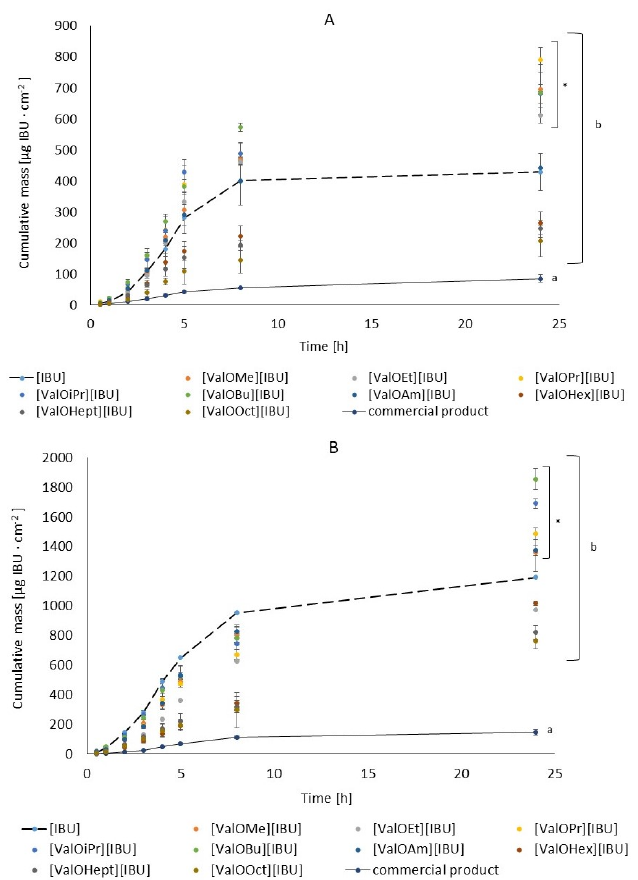
Figure 2. Time course of the cumulative amount of [IBU] and its modifications that permeated through human skin ( A ) and Strat-M™ ( B ). Five percent IBU and its derivatives in Celugel ® and commercial product single application 1 g·cm − 2 of human skin and Strat-M™. Each point represents the mean ± SD ( n = 3). For * p < 0.0001 versus the control (pure ibuprofen). Different letters also mean essential between Celugel ® (b) and commercial product (a).